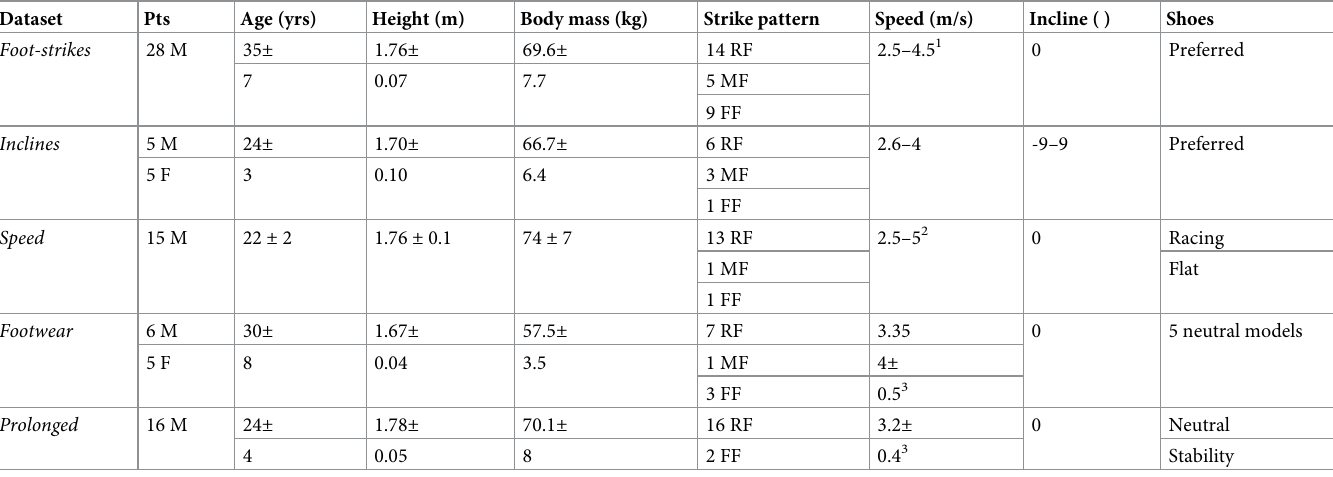
Table 1. Participant demographics and testing conditions.